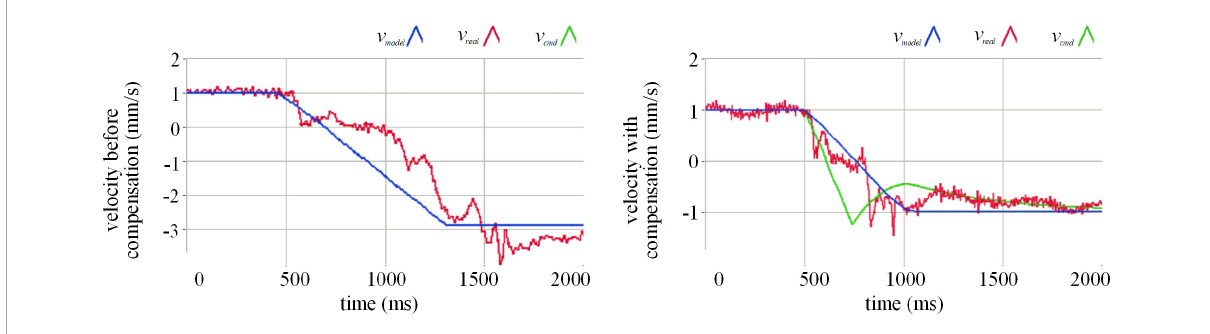
FIGURE5 The effect of lagging compensation.